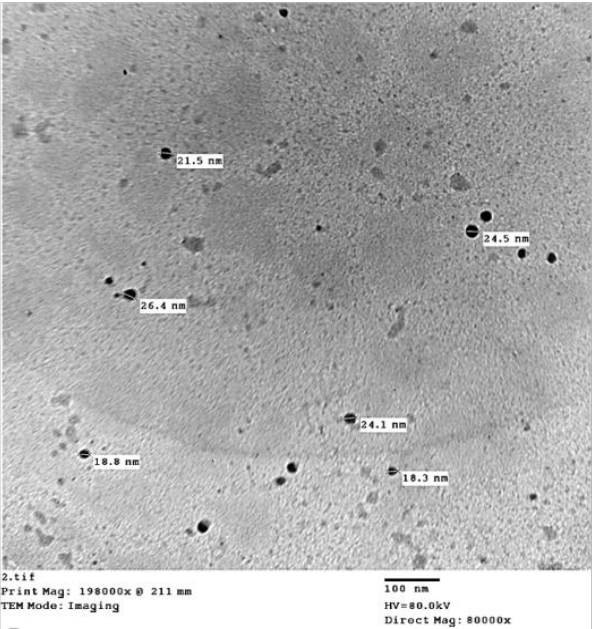
Figure 5. Potassium nanoparticles.